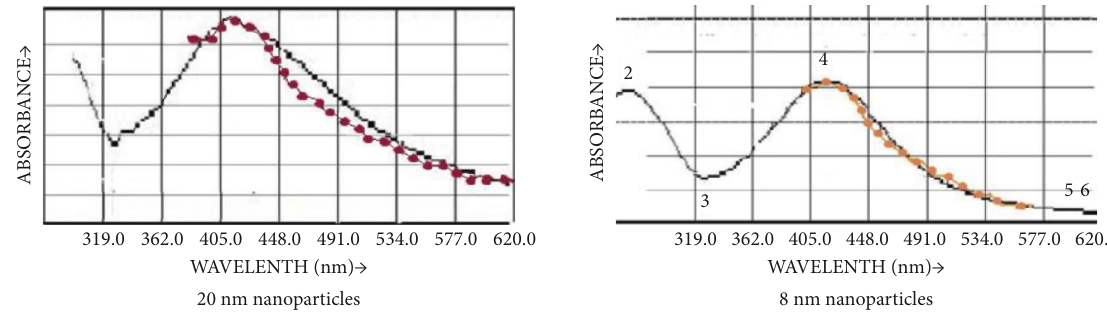
Figure 13: Experimental data from an advanced device (dashed lines) and reference values for a Vis spectrum of 8- and 20-nm silver nanoparticles are shown to be in good agreement